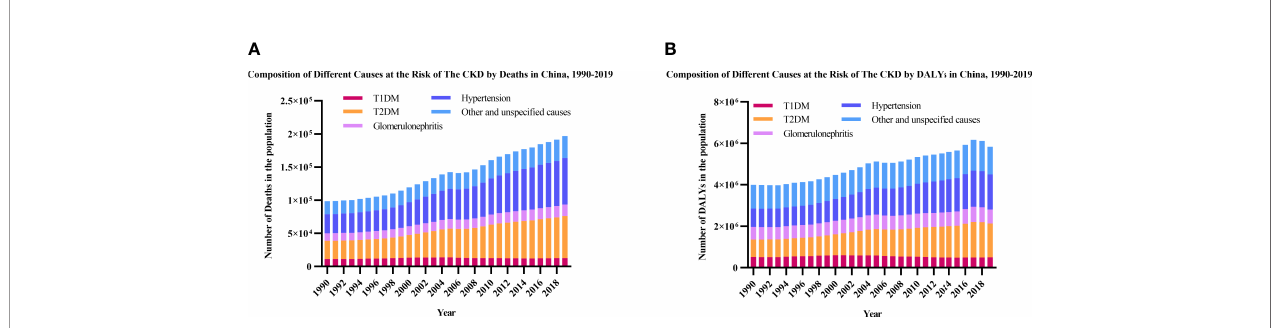
FIGURE 4 | Leading causes of CKD by year. (A) Number of deaths; (B) Number of DALYs. CKD, chronic kidney disease; T1DM, type 1 diabetes mellitus; T2DM, type 2 diabetes mellitus; DALYs, disability-adjusted